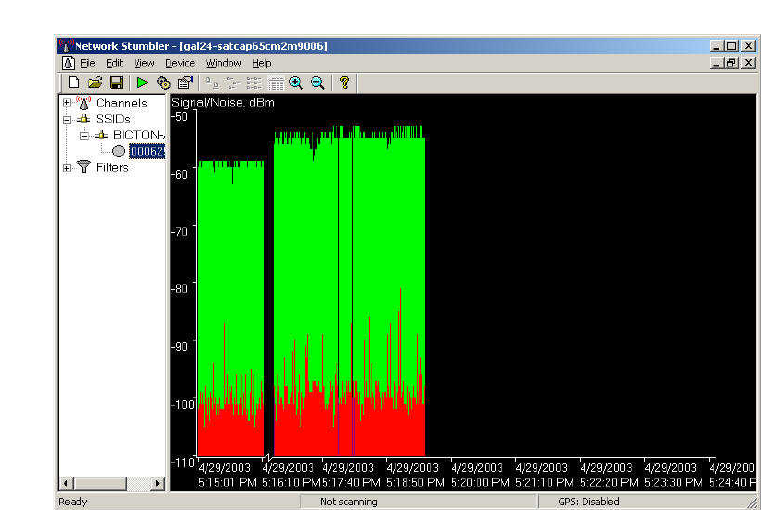
Slika 10 – Network Stumbler – Odnos signal/šum Figure 10 – Network Stumbler – Signal/Noise